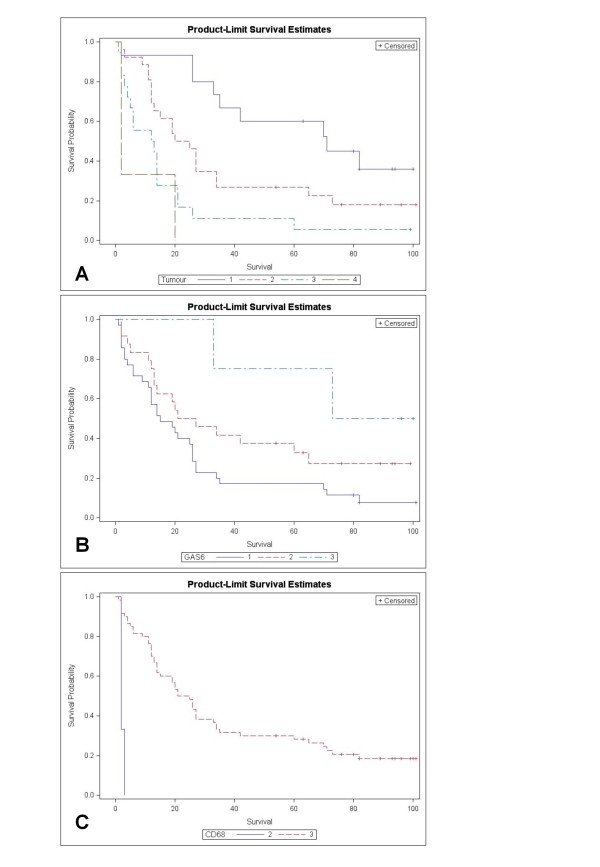
Product Limit Survival Estimates illustrate the significant impact of T, CD68 and Gas6 (Log rank) on survival of BC.